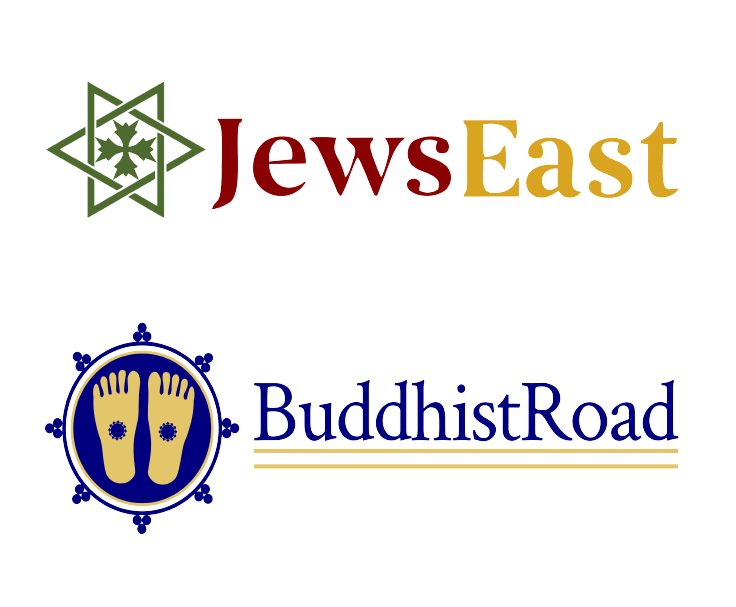
Figure 6 The ERC projects JewsEast and BuddhistRoad were inspired by the KHK and are both con- ducted in Bochum by former KHK